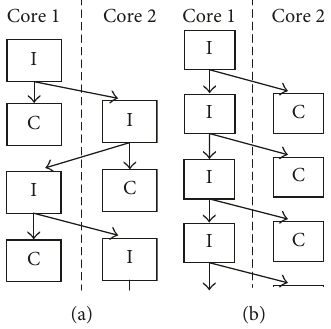
Figure 2: (a) DOACROSS. (b)